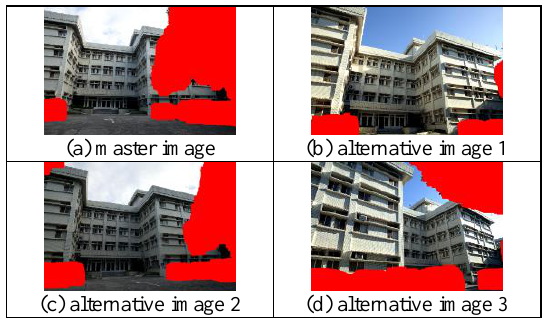
Figure 6. The results of occlusion detection for façade 3 Category from geometric shape